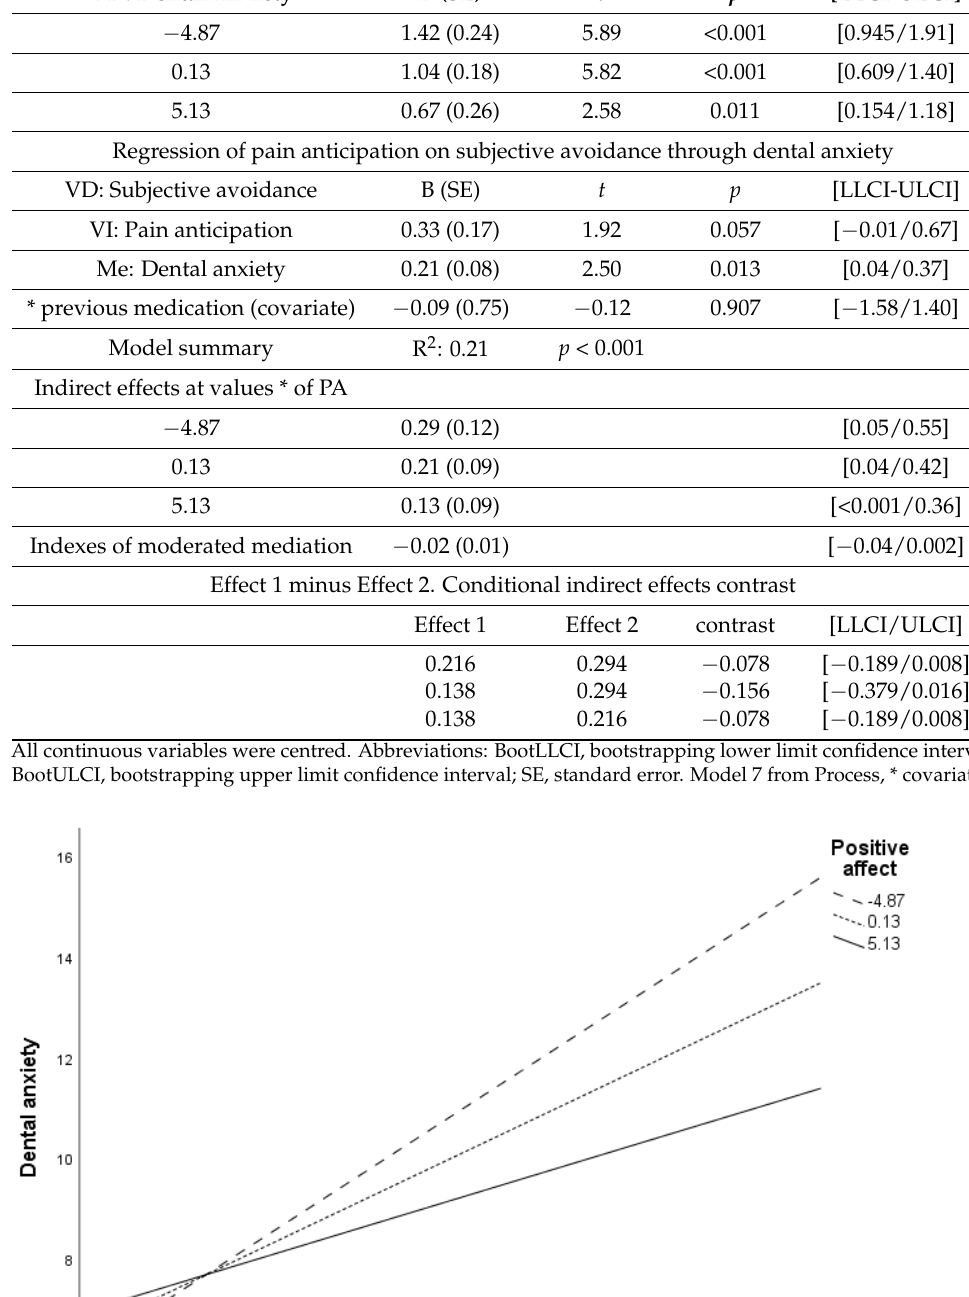
Figure 2. Pain anticipation on dental anxiety at different levels of positive affect. 4. Discussion This prospective study investigated whether dental anxiety mediated the effect of pain anticipation (before endodontic treatment) on the subjective avoidance of future dental treatments as a function of positive affect. Our results show a significant rela- tionship between pain anticipation, dental anxiety, and subjective avoidance. These re- sults are in accordance with the vicious circle model [34]. Due to the close associations between pain anticipation and dental anxiety found in previous studies, different au- thors, in the context of dental health, have used fear of dental pain constructs, which emerge as a concept that attempts to explain complex interactions between anxiety and pain [9]. A differential aspect of the current study is that subjective avoidance was measured separately from other variables associated with dental health, such as dental fear. In the study by Nermo et al. [11], patient avoidance was registered, requesting if patients had delayed any dental appointments because of fear. In our opinion, it is im-